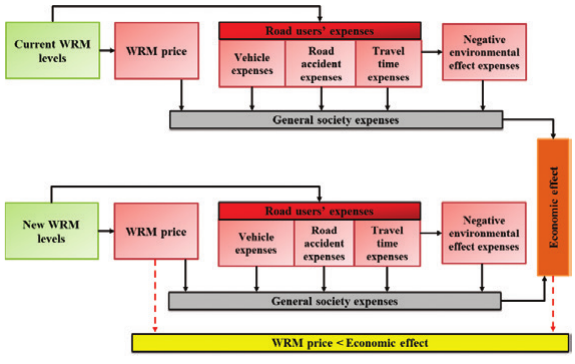
Fig. 4. The theoretical model scheme of winter road maintenance levels assessment (compiled by the author Ratkevičius, T)